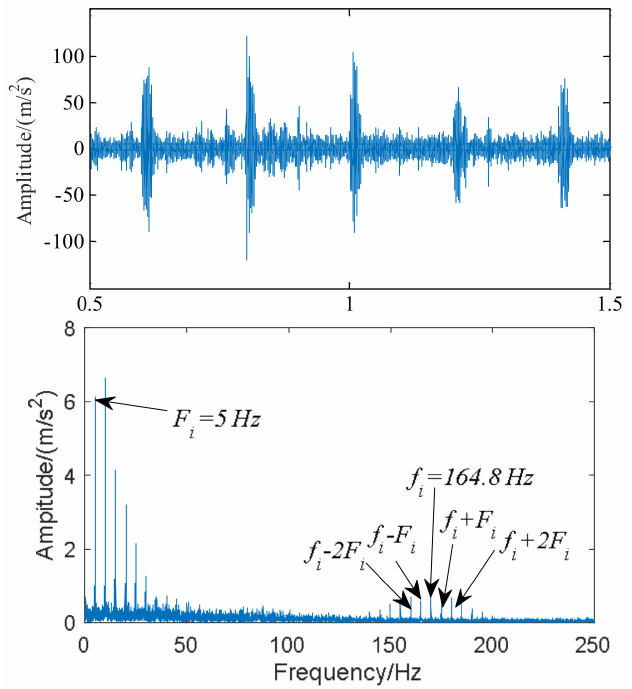
Figure 16. Time–domain signal and envelope spectrum of IR fault (experimental). (4) Simulation of the Inter-Shaft Bearing with Roller